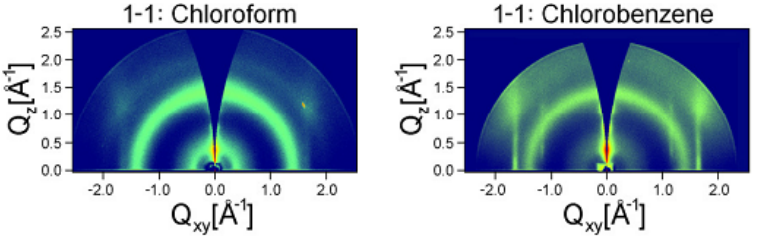
Figure 5. Grazing incidence wide-angle X-ray scattering (GIWAXS) images of a 1:1 P3HT:PCBM blend cast using chloroform (CF) and chlorobenzene (CB), respectively. Reprinted with permission from ACS